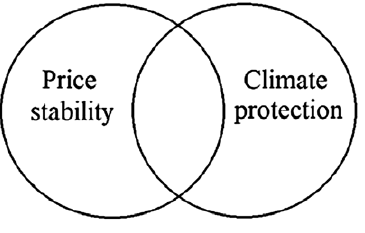
Figure 1: Price stability and climate protection, graphic by the